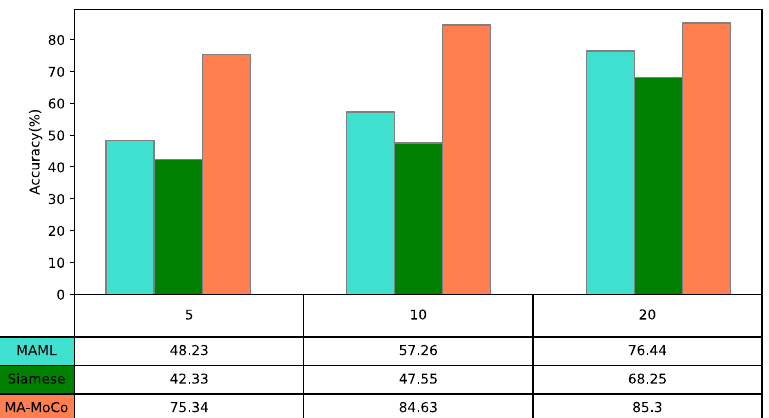
Figure 10. A 5-way 1-shot diagnosis of the accuracy of the wind turbine gearboxes data when the training set of each class has 5, 10, and 20 fault samples.